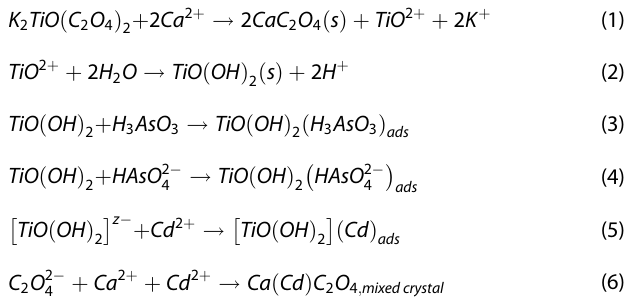
Supplementary Figure 10, there was no signi fi cant difference in Cd concentration between control and CaC 2 O 4 treatment, indicating preformed CaC 2 O 4 can ’ t effectively adsorb Cd 2 + . Importantly, in situ formed CaC 2 O 4 (K 2 C 2 O 4 treatment) precipitated 40% of Cd 2 + , and K 2 TiO(C 2 O 4 ) 2 precipitated 98% of Cd 2 + , suggesting occlusion with in situ formed CaC 2 O 4 and electrostatic adsorption by negatively charged Ti(OH) 4 maybe the two main pathways of Cd 2 + removal by K 2 TiO(C 2 O 4 ) 2 . Based on these results, a possible mechanism was proposed. After addition of K 2 TiO(C 2 O 4 ) 2 to drinking water, it hydrolyzes and reacts with the natural Ca 2 + in water to form hydrous TiO 2 (or TiO(OH) 2 ) and crystalline CaC 2 O 4 (Eqs. 1 and 2). As(III) and As(V) are adsorbed on the TiO(OH) 2 particle surface and removed from water (Eqs. 3 and 4). Because of the negative surface charges of TiO(OH) 2 , some Cd 2 + is also adsorbed on the TiO(OH) 2 particle surface (Eq. 5). Because of the similar chemical valences and ionic radii of Cd and Ca, most of the Cd was encapsulated inside the lattice of CaC 2 O 4 , forming Cd-doped Ca(Cd)C 2 O 4 mixed crystal (Eq. 6). Overall, adding K 2 TiO(C 2 O 4 ) 2 enabled the comprehensive utilization of Ti and C 2 O 4 2 − while the only byproduct was K + (no Ti and C 2 O 42 − were detected in the ef fl uent), which is a healthy element for humans (Fig. 8). A bonus advantage is decreased water hardness and improved taste due to the C 2 O 42 − precipitation of natural Ca 2 + /Mg 2 + .